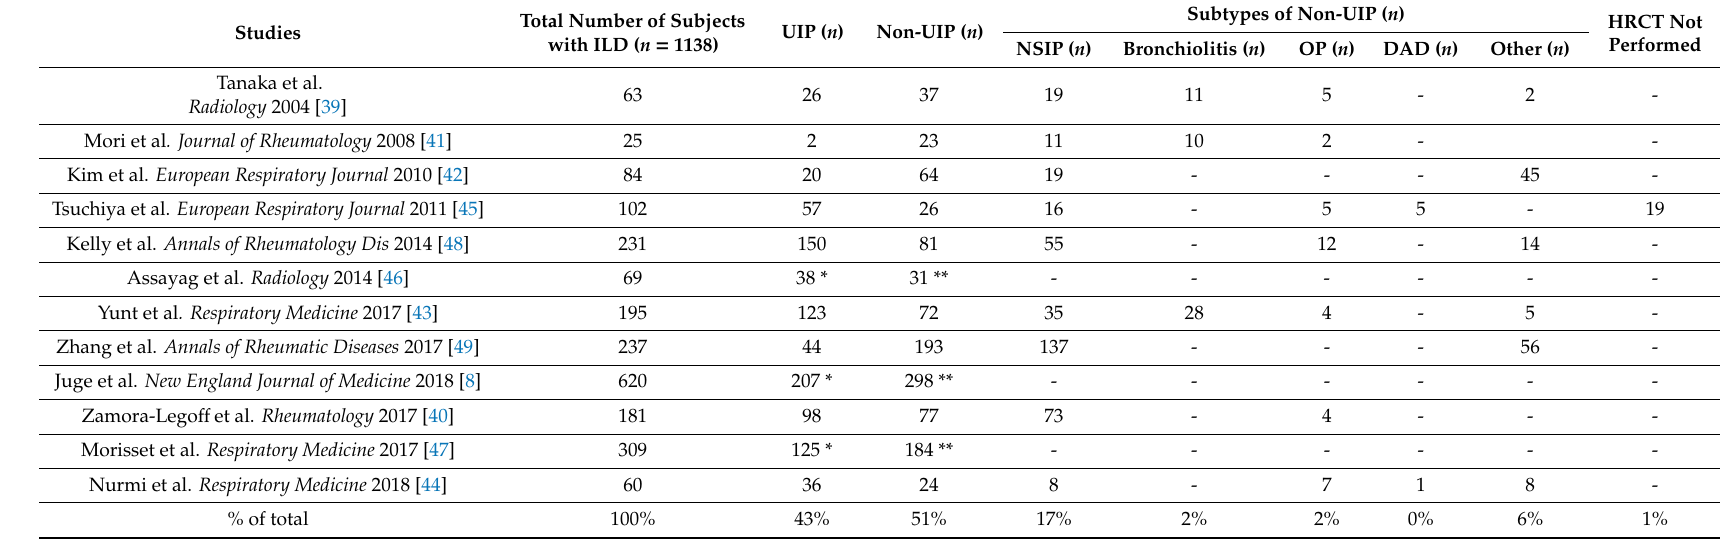
Table 1. High-resolution computed tomography (HRCT) patterns in patients with rheumatoid arthritis-associated interstitial lung disease (RA-ILD). Subtypes of Non-UIP ( n ) HRCT Not Total Number of Subjects UIP ( n ) Non-UIP ( n ) Studies with ILD ( n = 1138) PerformedNSIP ( n